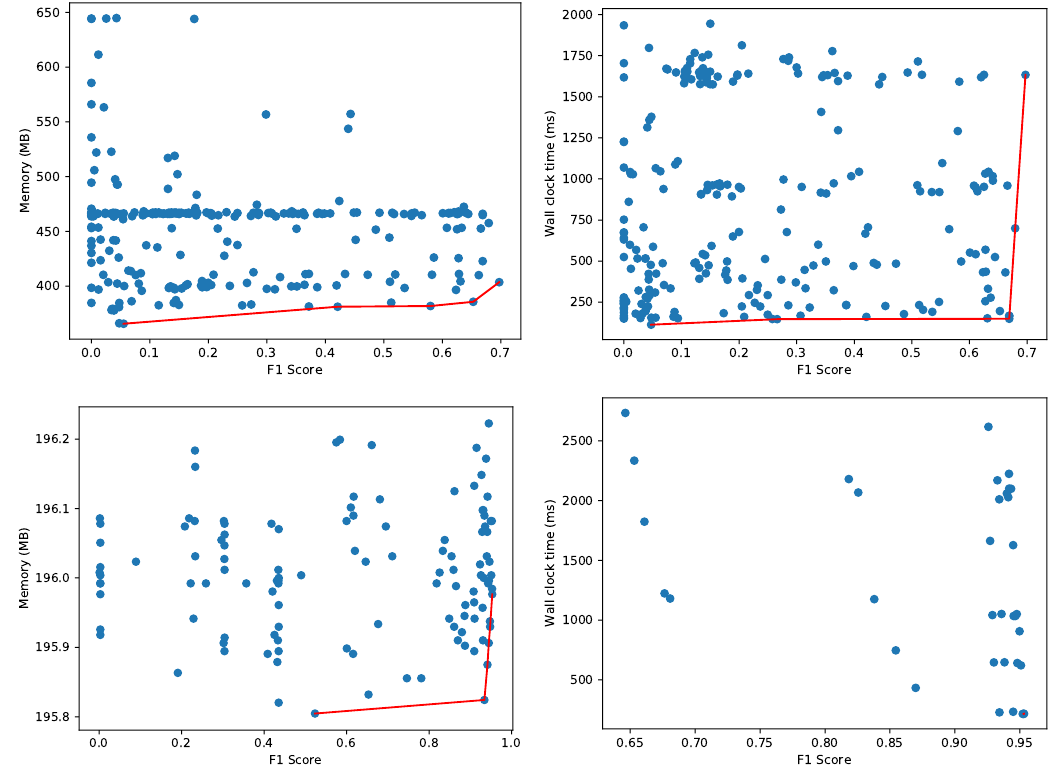
Figure 14. Pareto fronts for memory ( left ) and wall clock time ( right ) for the Enterprise anomaly dataset re-using AutoSklearn ( top ) and One-Class SVM ( bottom ) models for different